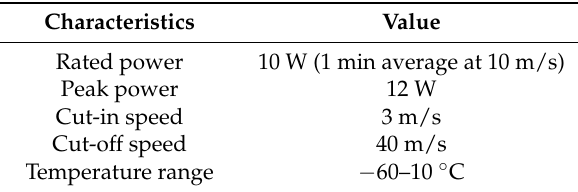
Table 3. Key specifications of the TYUT wind